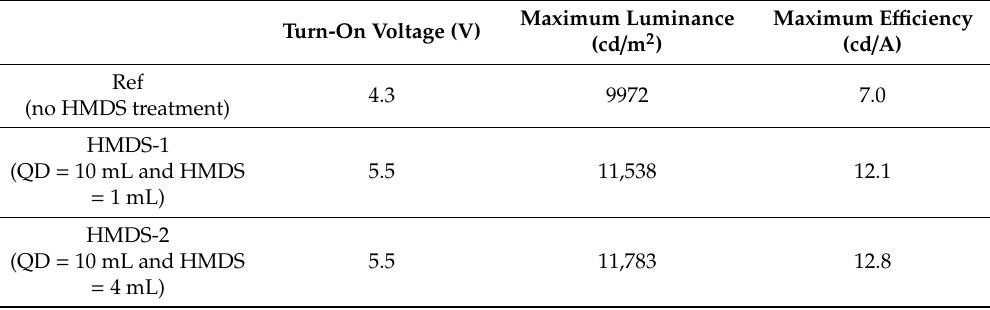
Table 1. The e ff ects of the hexamethyldisilazane (HMDS) treatment on the characteristics of quantum dot light emitting diodes (QD-LEDs). Note that the ratio of HMDS-1 to of quantum dot (QD) was 1 / 10 and the ratio of HMDS-2 to QD was 4 /